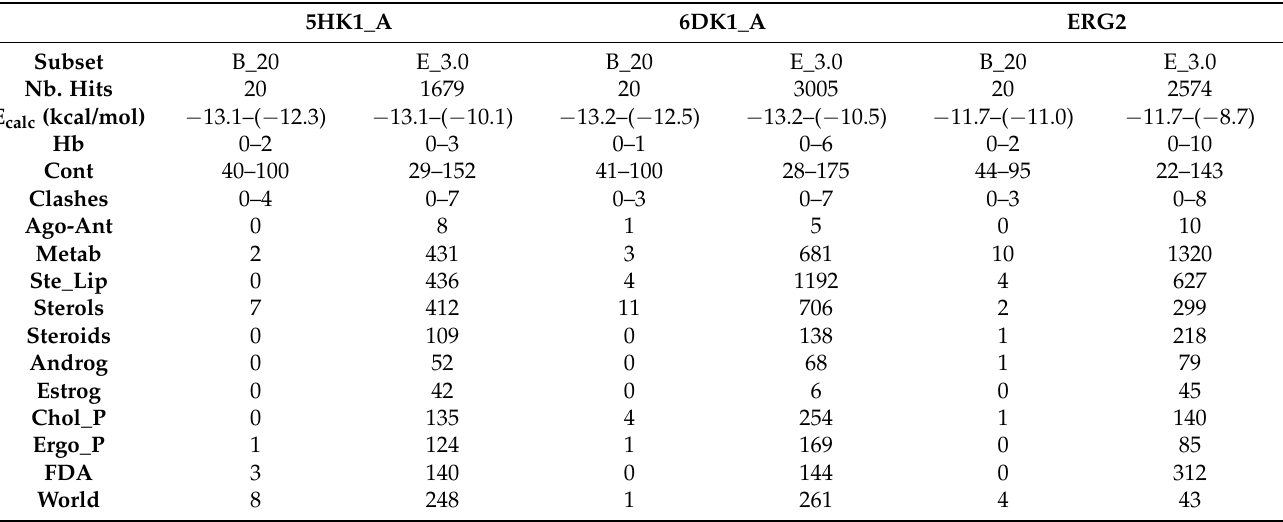
Table 1. Summary of the results of VS experiments against the 3D structures of Hs σ 1-R in coordinate files 5HK1 and 6DK1 and the molecular model of yeast ERG2. 5HK1_A and 6DK1_A: monomer with chain ID “A” in coordinate files 5HK1 and 6DK1, respectively. ERG2: molecular model of yeast ERG2 protein built by AlphaFold2. B_20: 20 hits with lowest calculated interaction energy (E calc ) with the target structure. E_3.0: “best-E3”, namely hits whose E calc with the target structure is ≤ 3.0